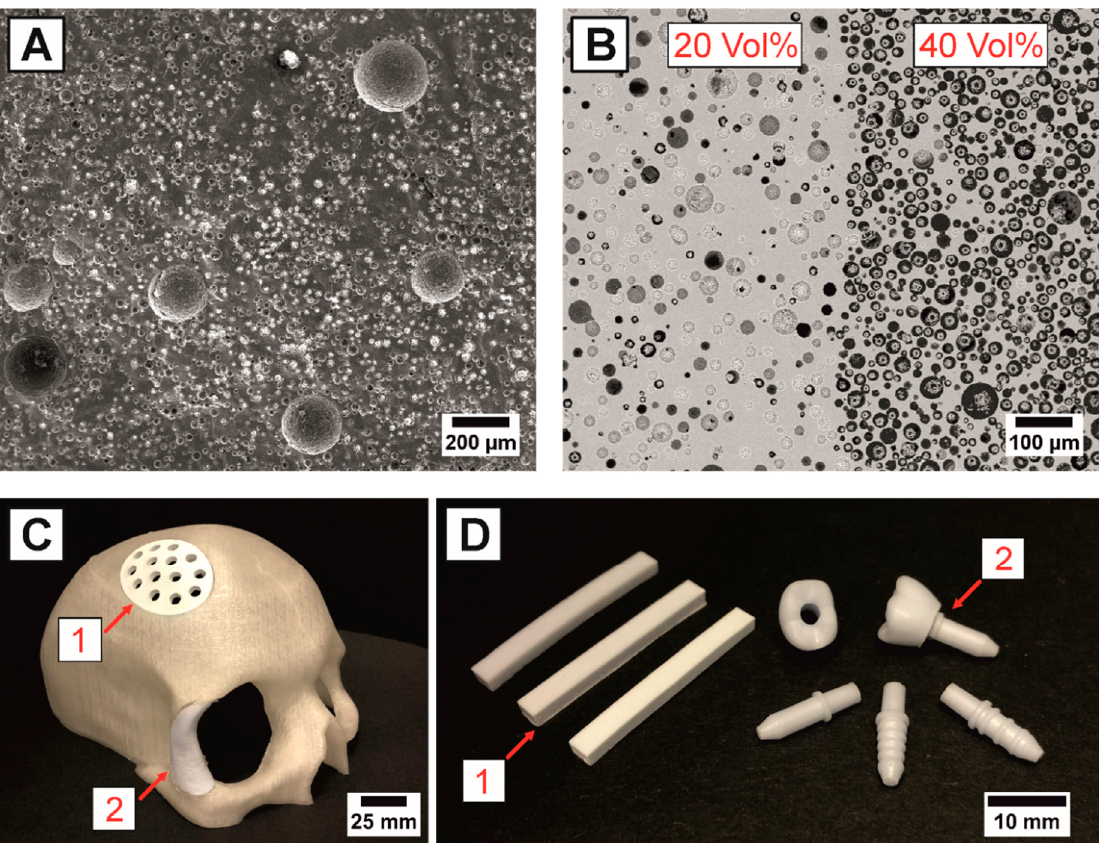
Figure 6. Future perspectives for porous HAp ceramics and HAp/UDMA composites fabricated by porous injection molding: Microstructure of a porous HAp sample with a bimodal pore size distribution containing 5 Vol% of 200 µm and 15 Vol% of 20 µm spherical pore formers ( A ). Polished SEM-micrograph of a HAp sample with a graded porosity, showing the defect-free interface between two layers containing 20 Vol% and 40 Vol% of 20 µm spherical pore formers ( B ). Potential non-load bearing cranial (1) and maxillofacial (2) implants for the porous HAp ceramics ( C ). Fabricated porous HAp bending bars with 0, 10 and 30 Vol% of pore formers (1) and potential two-part dental implants for the interpenetrating HAp/UDMA composites (2), showing a ceramic crown and three types of abutments with different anchoring geometries ( D ).